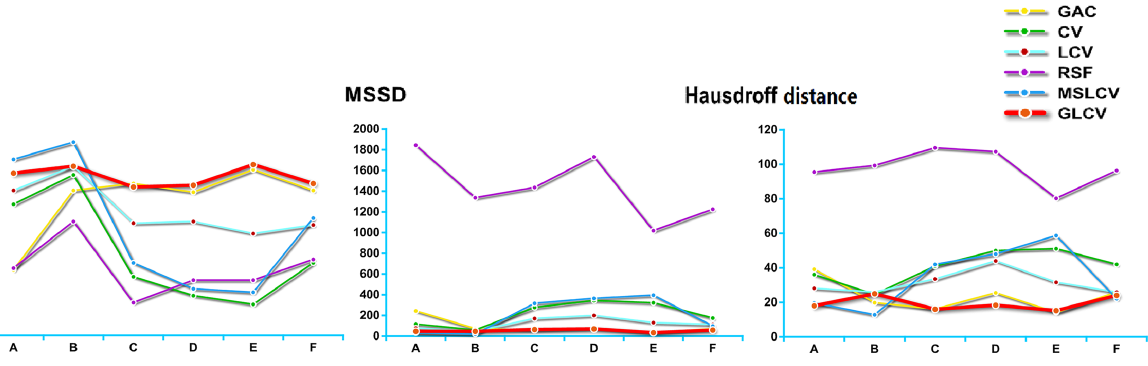
Fig 3. Comparisons of computed DSC [36], MSSD [37] and Hausdroff distance [37] utilizing GAC [19], CV [20], LCV [22], RSF [23], MSLCV [24] and GLCV methods for segmentation of HIFU ultrasound images. The red lines are the performance line of GLCV, indicating the GLCV method achieves the best segmentation